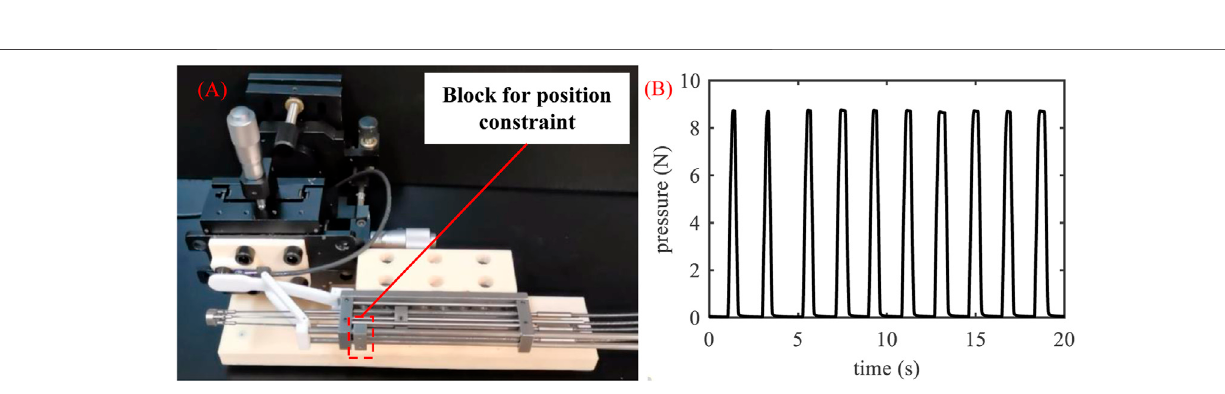
FIGURE 6 | Pressure tests of the tongue depressor, (A) Process of the tests, (B) The pressure of the tongue depressor with time.